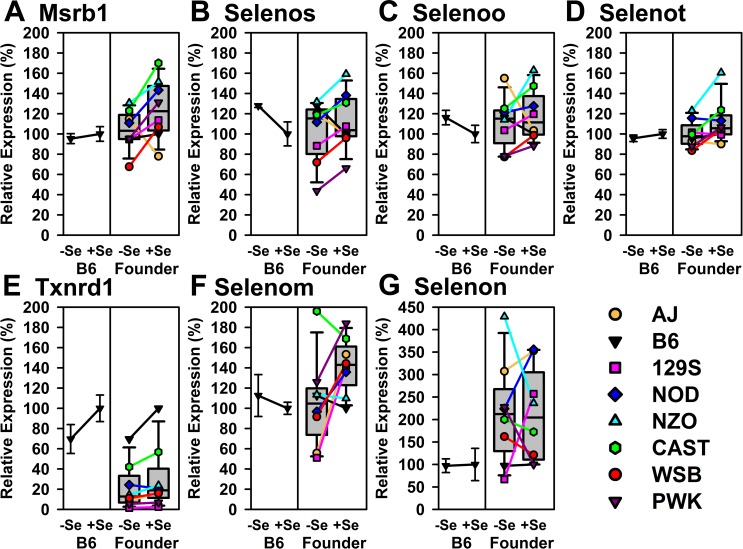
Relative expression of liver selenoprotein transcripts not altered significantly by Se deficiency in B6 or Founder mice.Shown are expression levels for Msrb1, Selenos, Selenoo, Selenot, Txnrd1, Selenom, and Selenon, expressed relative to the level in +Se B6 mice. Details as described for Fig 4.